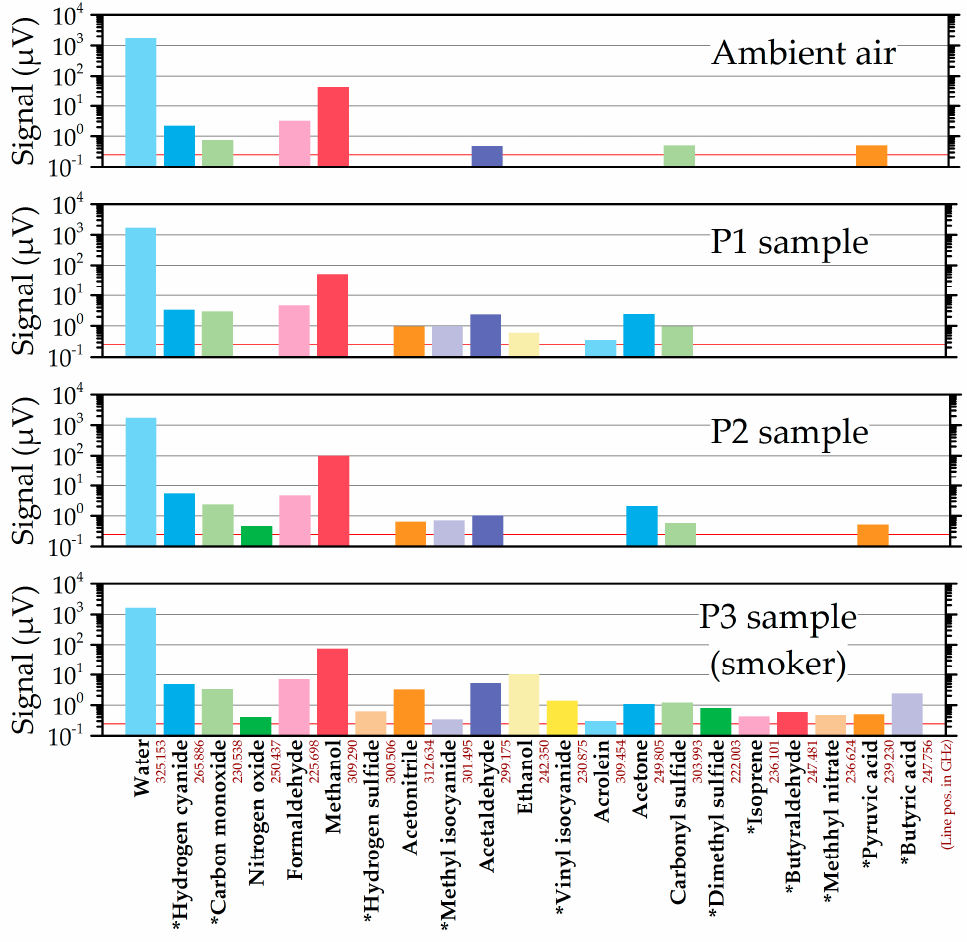
Figure 4. Results of the absorption line scans for ambient air and the three volunteers’ samples. For each detected species, the maximum peak-to-peak signal of the stronger absorption line is shown. Molecules, which were detected by only one transition, are marked by a star. The root-mean-square (RMS) noise level of 250 nV is indicated by the red line. The red numbers are the line positions in GHz.